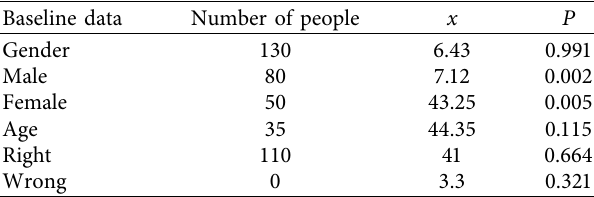
Table 1: Ankle fracture in sports.